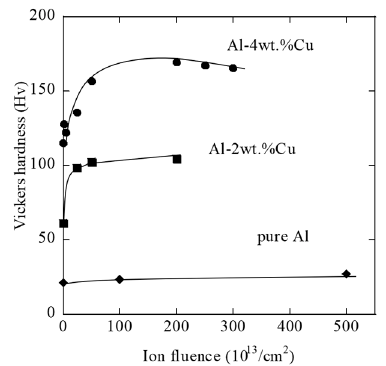
Figure 2. Vickers hardness as a function of 16 MeV Au ion fluence for pure Al, Al-2wt% Cu alloy and Al-4wt %Cu alloy.